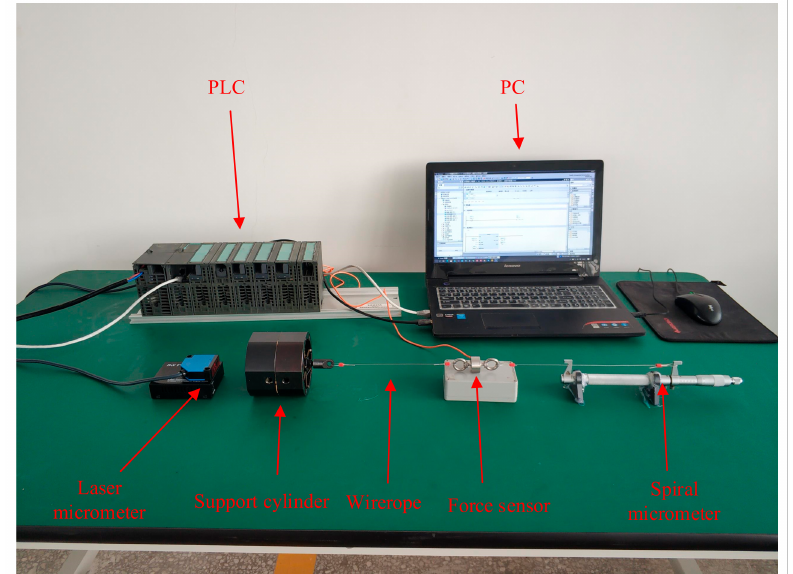
Figure 16. Internal resistance measurement test